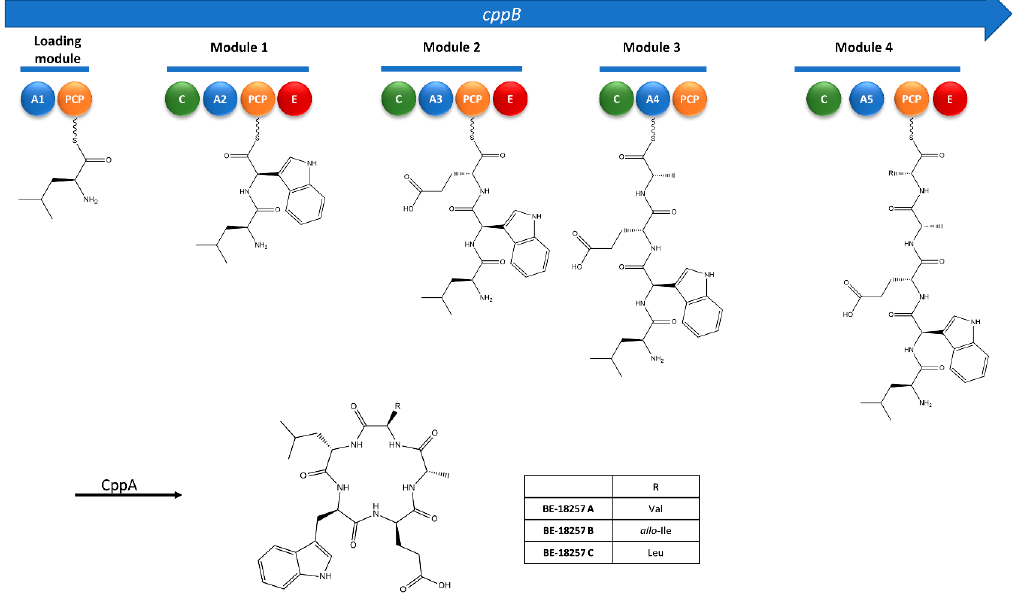
Figure 5. Proposed biosynthetic pathway for the BE-18257 A–C antibiotics with the non-ribosomal peptide synthetase CppB modular organization. A1-A5, adenylation domains; PCP, peptidyl carrier protein; C, condensation domain; E, epimerase domain; CppA, PBP-type TE.